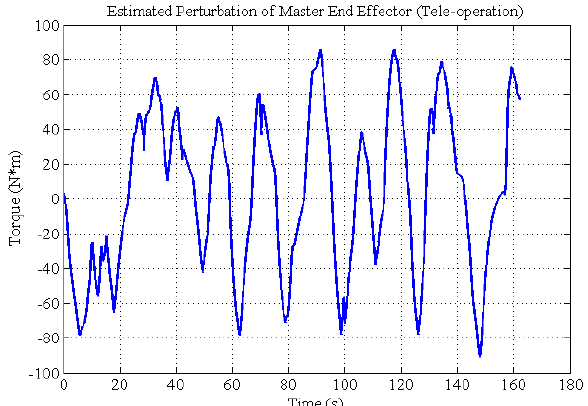
Figure 12. Estimated perturbation of the master end effector.